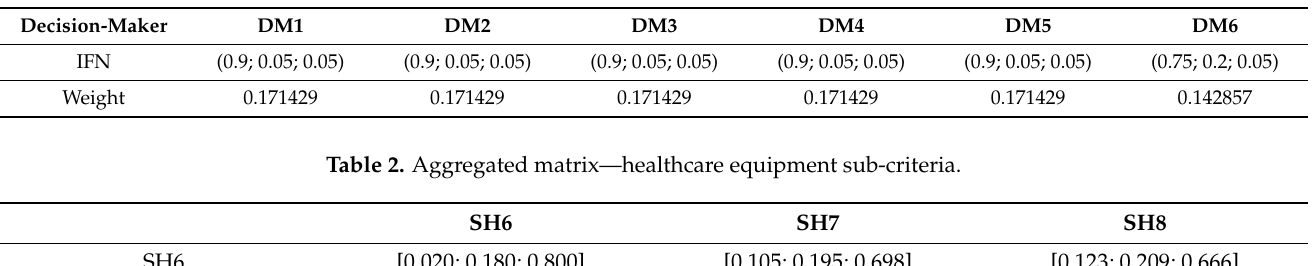
Table 1. Relative priorities of decision-makers and their IFNs.